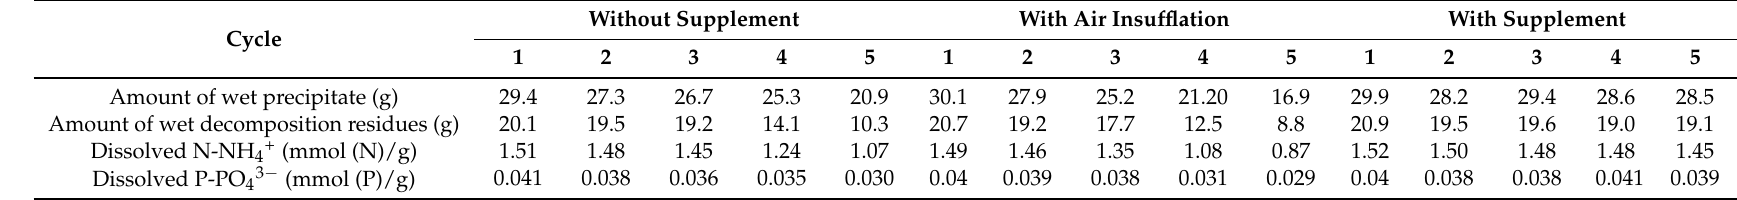
Table 2. Amounts of produced precipitate, decompositions residues, and solubilized N-NH 4+ and P-PO 43 − detected during the treatment cycles.